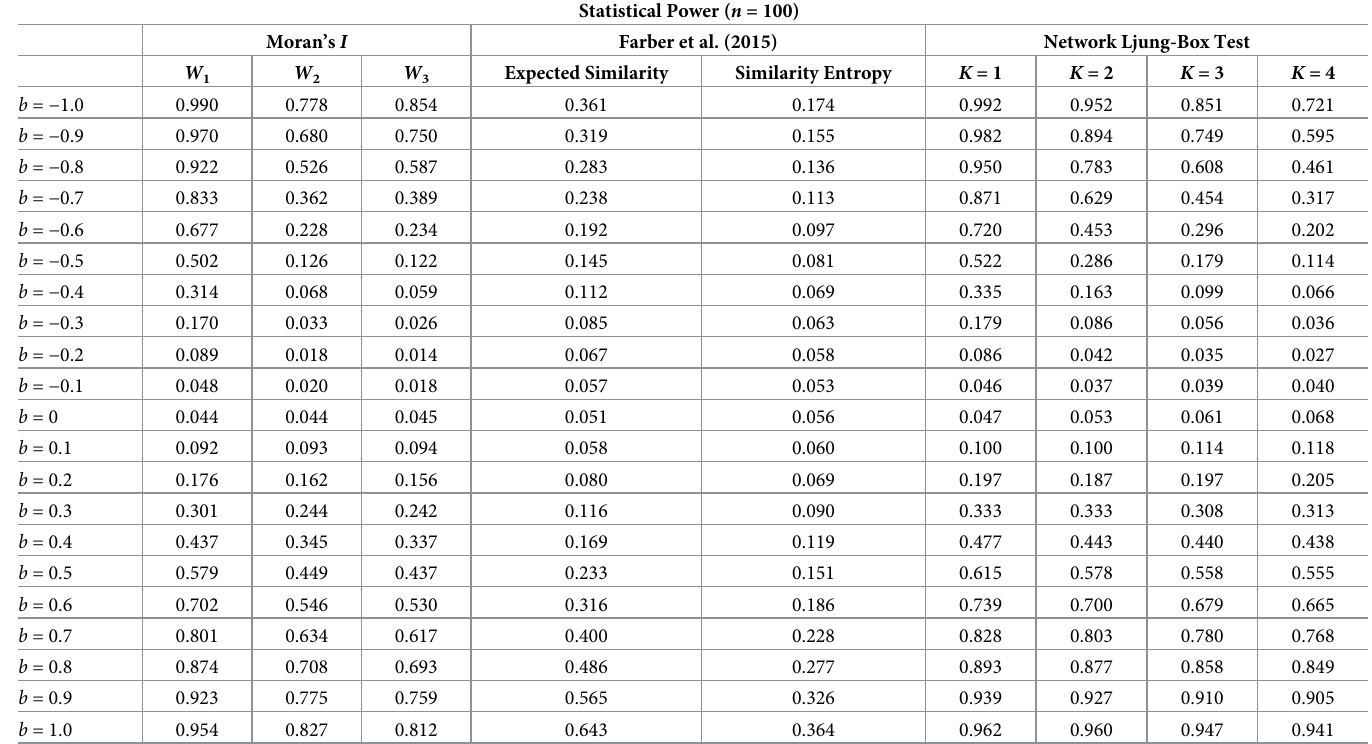
Table 4. Statistical power vs. network autocorrelation. Statistical power of tests for different values of b with n =